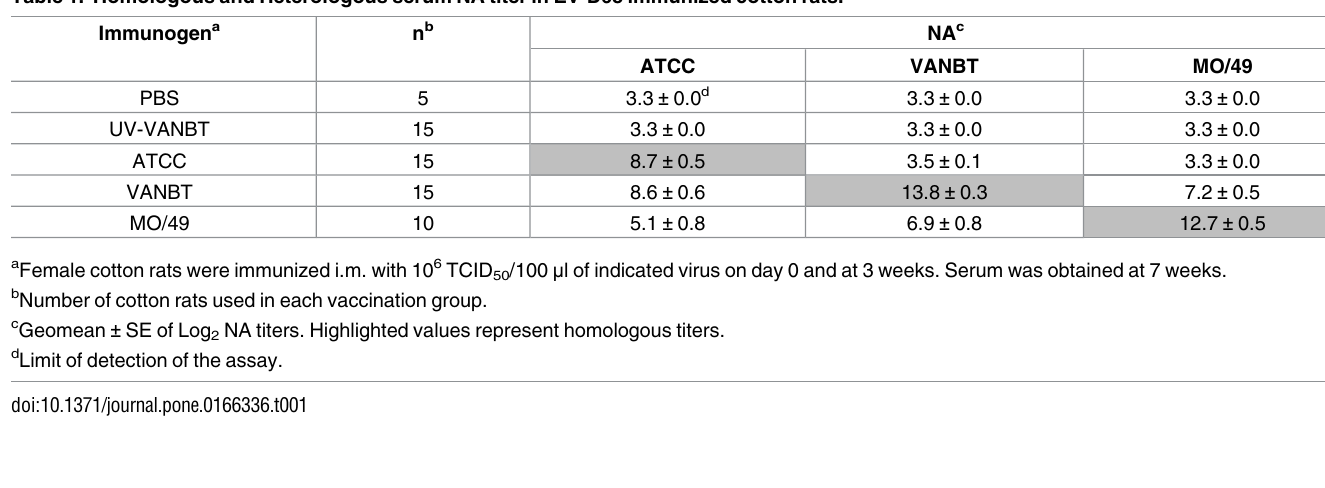
Table 1. Homologous and Heterologous serum NA titer in EV-D68 immunized cotton rats. Immunogen a